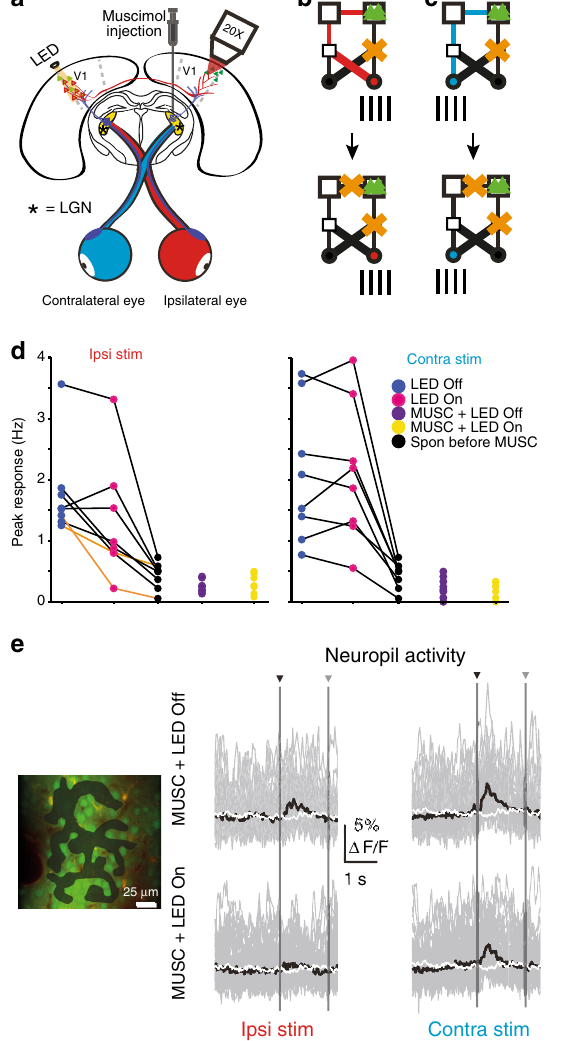
Fig. 5 Activation of callosal pathway alone from either eye is not suf fi cient to drive spiking. a Schematic of experimental design showing inactivation of ipsilateral LGN (muscimol injection) and reversible inactivation of vc pathway. b Cartoon depicting pathways deactivated during muscimol injection (upper) for ipsilateral stimulation and for experiments with muscimol injection and vc pathway inactivation (lower). c Cartoon depicting pathways deactivated during muscimol injection (upper) for contralateral stimulation and for experiments with muscimol injection and vc pathway inactivation (lower). d Comparison of spiking response for maximum response angle during ipsilateral (left, 8 neurons, ipsilaterally responsive, 2 animals) and contralateral (right, 8 neurons, contralaterally responsive, 2 animals) only stimulation. Control (dark blue, no muscimol), vc pathway inactivation (magenta), LGN inactivation (purple), and LGN inactivation with vc pathway inactivation (yellow). Spontaneous activity rates (black) shown for each neuron. Ipsilateral responses not different to spontaneous activity on vc pathway silencing indicated by orange lines. e Left panel, example fi eld of view with labeled neuropil ROI (shaded area); right panel, neuropil responses evoked by stimulation of ipsilateral (left) or contralateral (right) eye recorded during silencing of ipsilateral LGN without (upper) and with VCPN-inactivation (lower). Individual (gray) and average (black) responses. Shuf fl ed neuropil responses (white). Stimulus onset (black arrow head) and offset (gray arrow